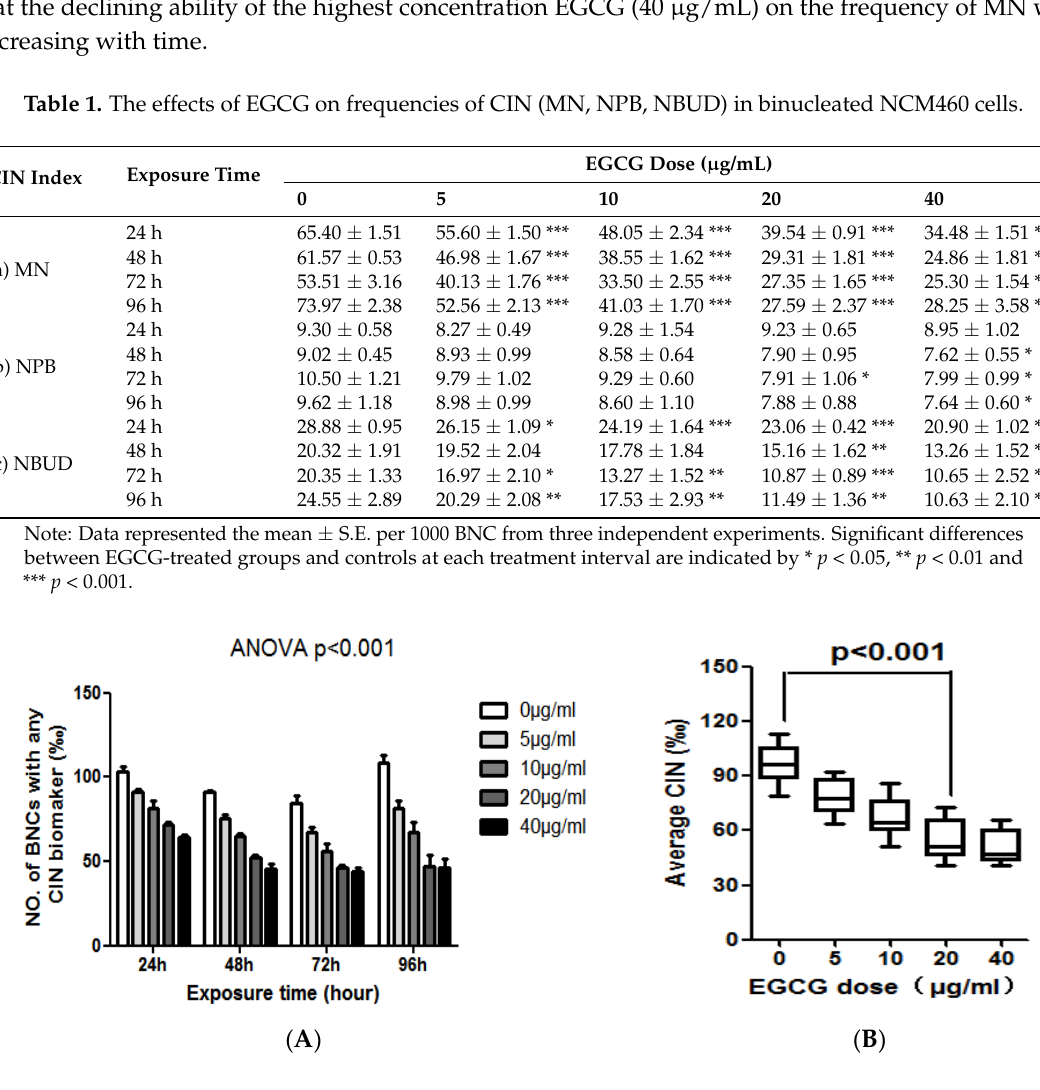
Table 1. The effects of EGCG on frequencies of CIN (MN, NPB, NBUD) in binucleated NCM460 cells.